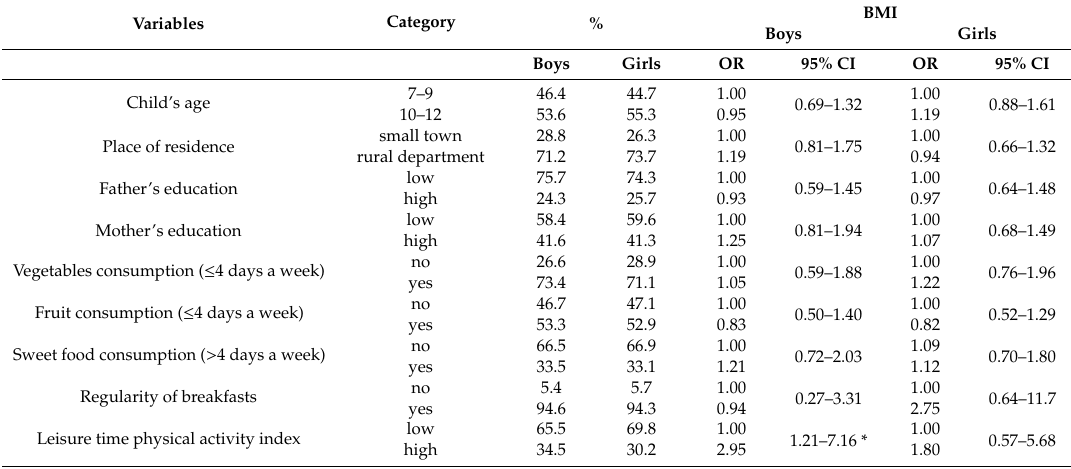
Table 4. Factors associated with thinness (BMI) in rural boys and girls.